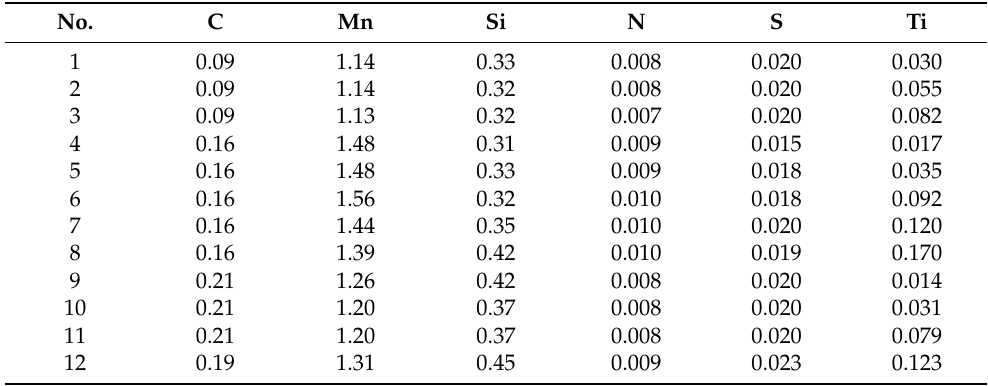
Table 3. Chemical composition of steels studied in [27].